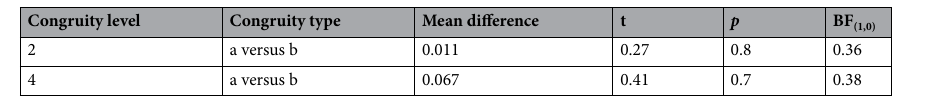
Table 5. Comparison within the same congruity level. The congruity types (a–b) are detailed in Table